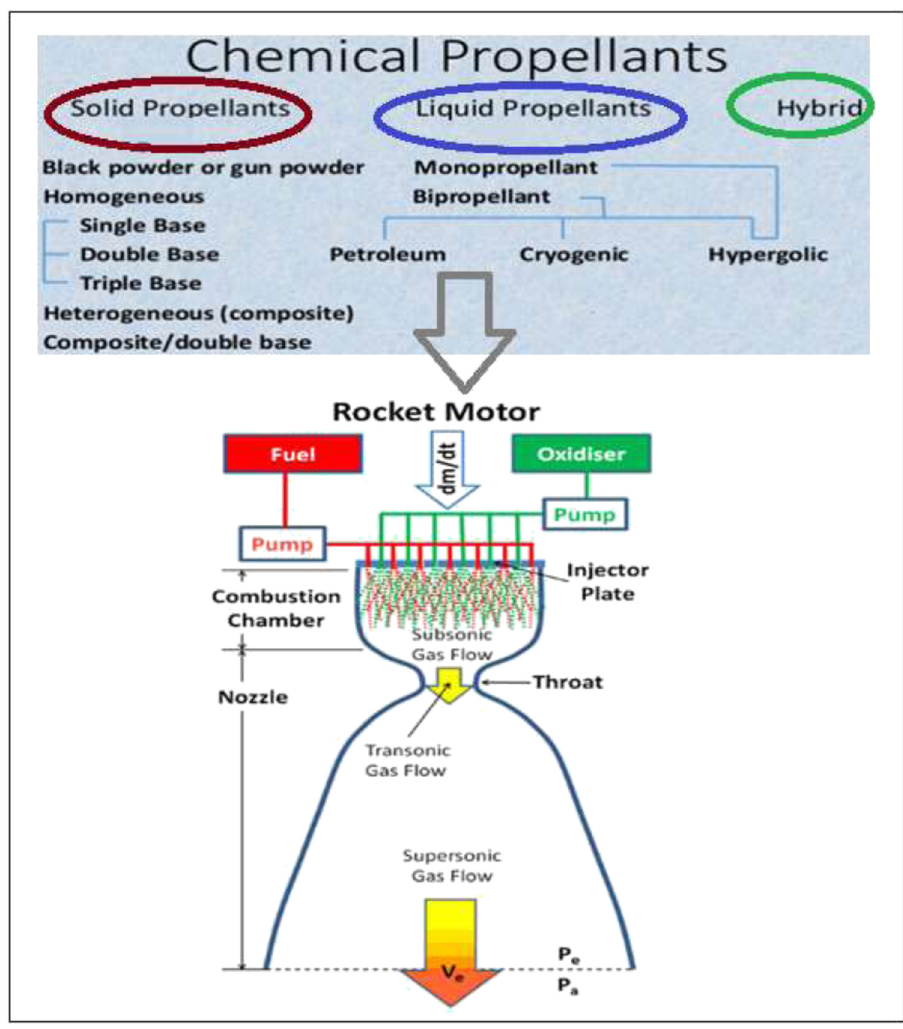
Figure 1: Classi fi cation and schematic diagram of rocket